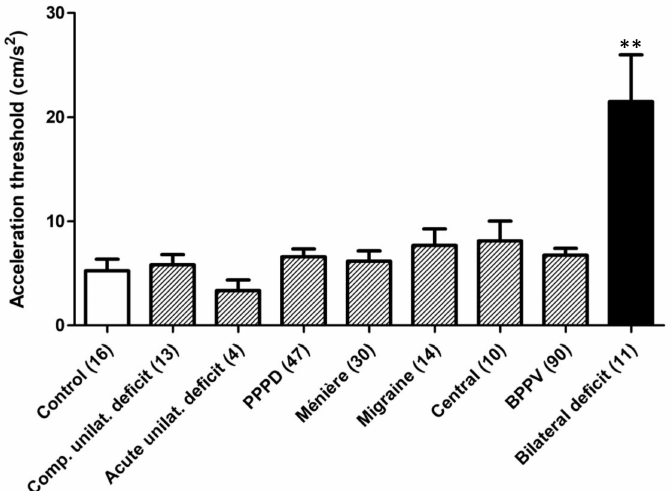
Figure 4. Acceleration thresholds as a function of etiology. Patients with bilateral vestibular deficit had higher acceleration thresholds (** adjusted p = 0.0033, Kruskall–Wallis test followed by